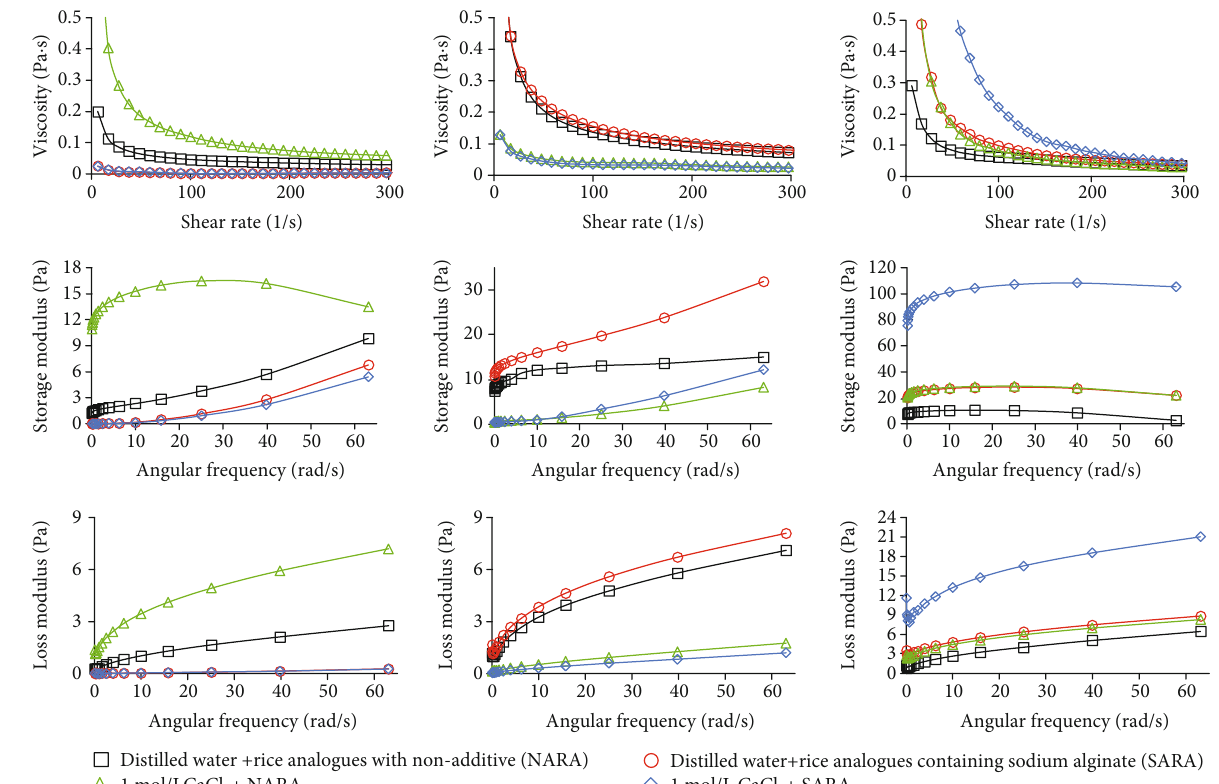
Figure 3: Rheological properties. (a) Escaping substances. (b)Adhesive layer. (c) Cooked rice analogues.